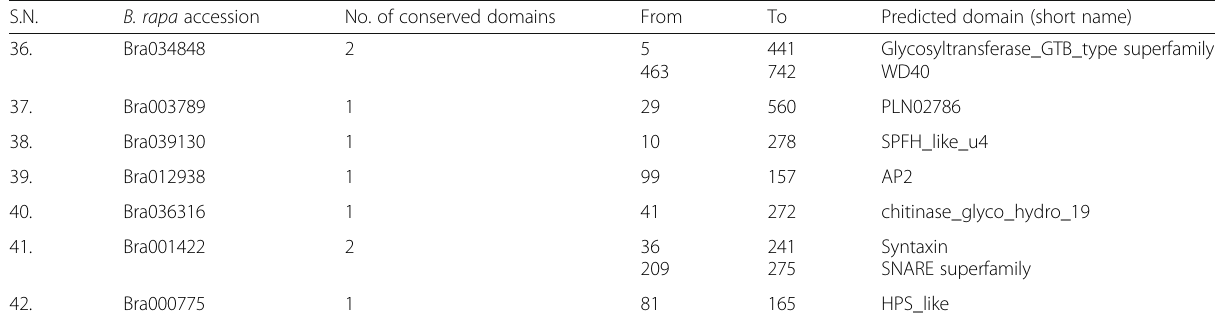
Table 5 Predicted conserved domains in identified upregulated Brassica rapa sequences with their positions under contrast ETMC (Continued) S.N.